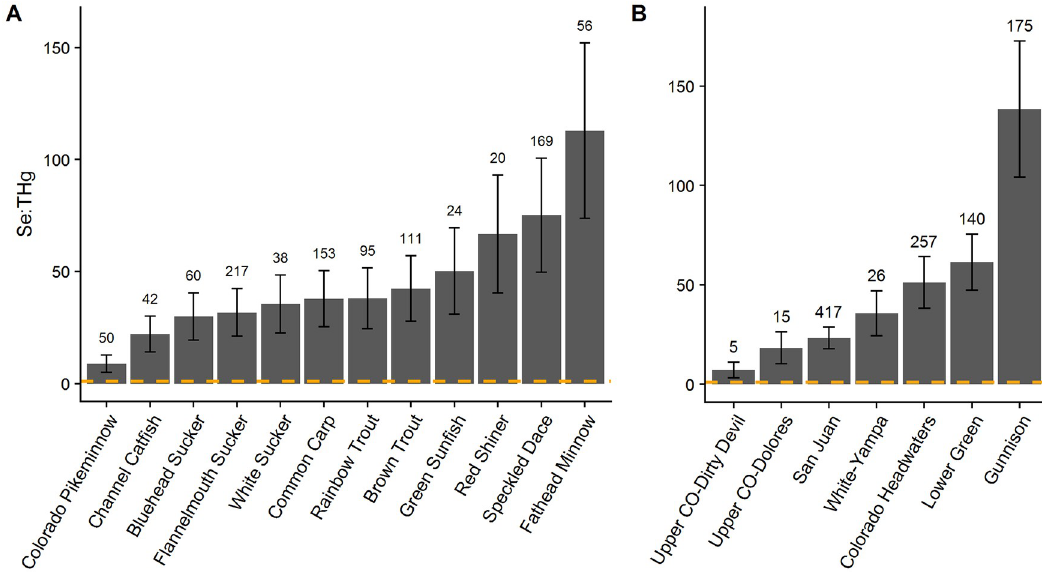
Fig 4. Least-squares means selenium: Mercury (Se:Hg) molar ratios of fish species (A) and assemblages (B) in the Upper Colorado River Basin. Bars are least-squares means controlling for the effects of site, tributary, and year (A) and site, species, and year (B), where appropriate. Error bars represent one standard error. Numbers above error bars indicate sample size. Dotted line represents a 1:1 molar ratio, which is thought to be protective of fish health.